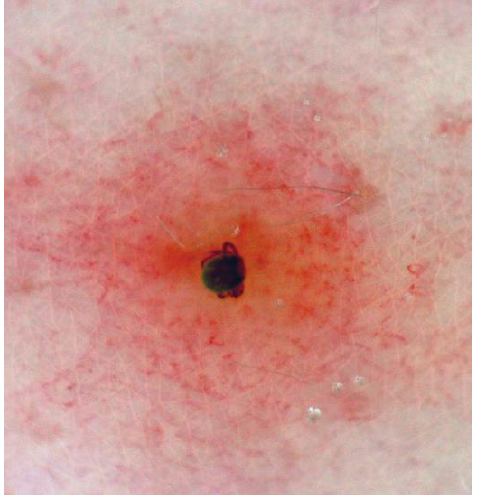
FIGURE 2. Dermoscopic findings of tick